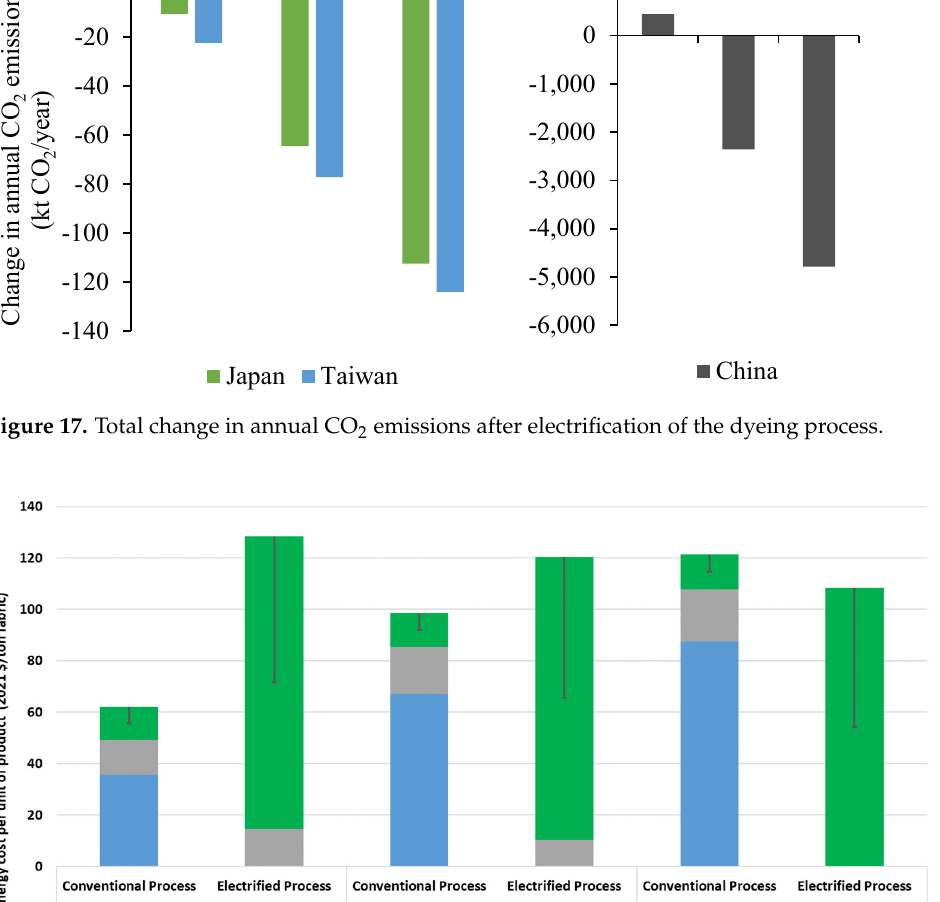
15 of 28 Figure 16. Total annual final energy savings after electrification of the dyeing process.